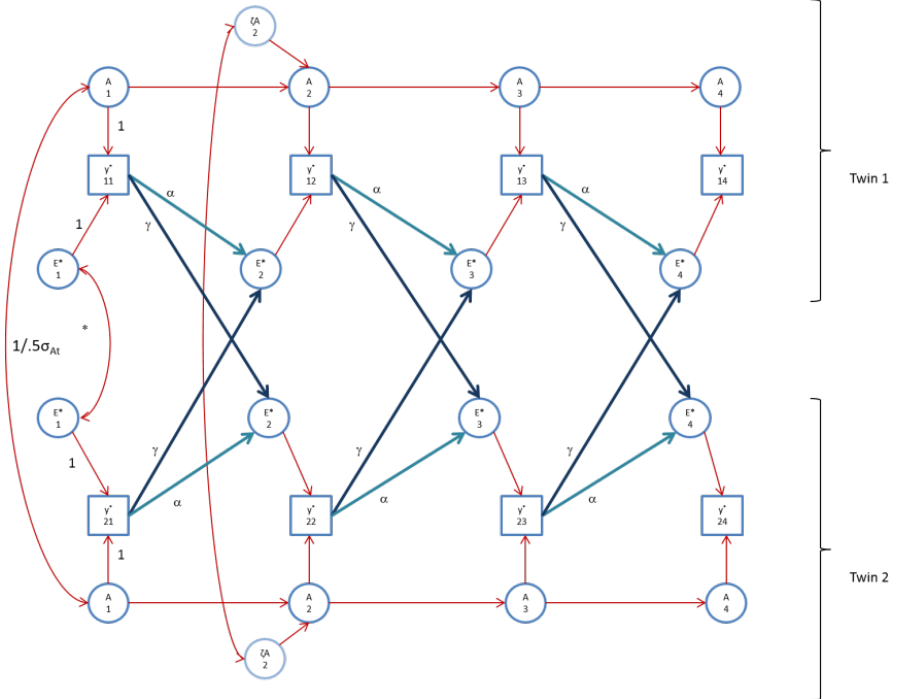
Figure 3. The AE* simplex model with Ph->E transmission as fitted to FSIQ. Time specific effects are not shown. Note that in FSIQ, time specific effects were found to be environmental (time specific genetic variance was zero).